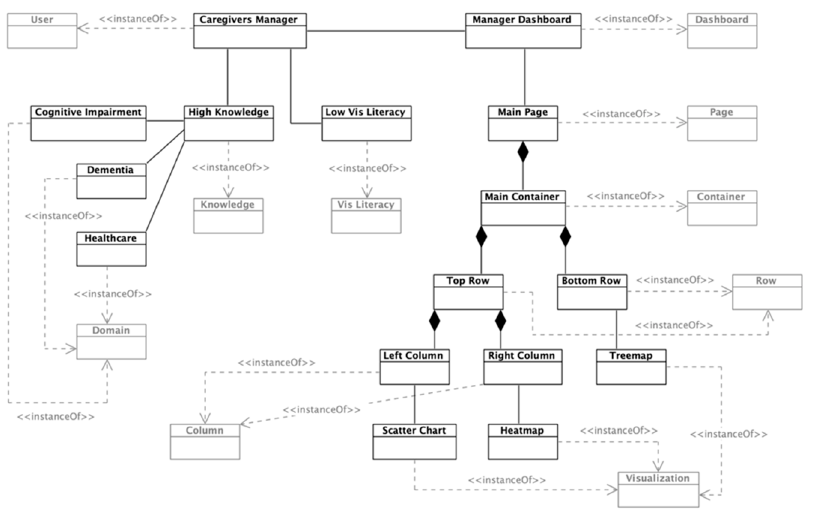
Figure 5. Dashboard meta-model instantiation regarding the user profile and dashboard